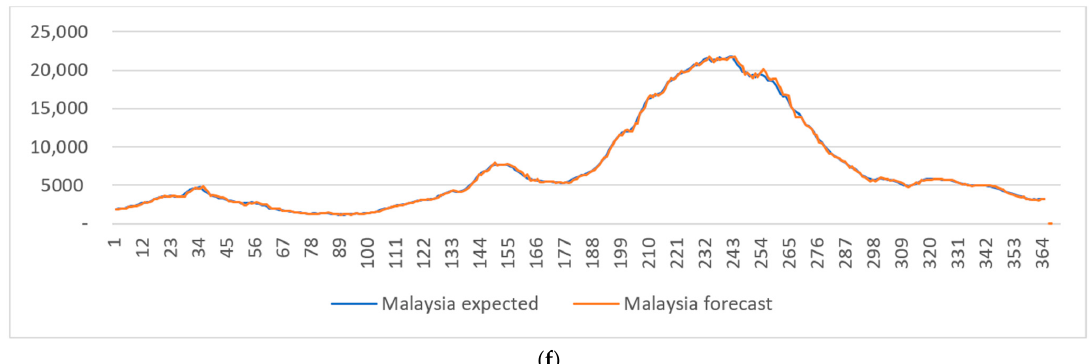
Figure 5. Prediction diagrams of COVID-19 daily confirmed infection cases obtained for the year 2021, versus the real daily number of infection cases for ( a ) Chile, ( b ) the Netherlands, ( c ) Canada, ( d ) Spain, ( e ) South Africa, and ( f ) Malaysia.